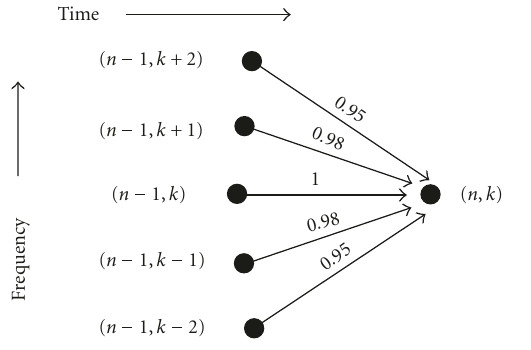
Figure 7: Dynamic programming local constraint for path tracking.